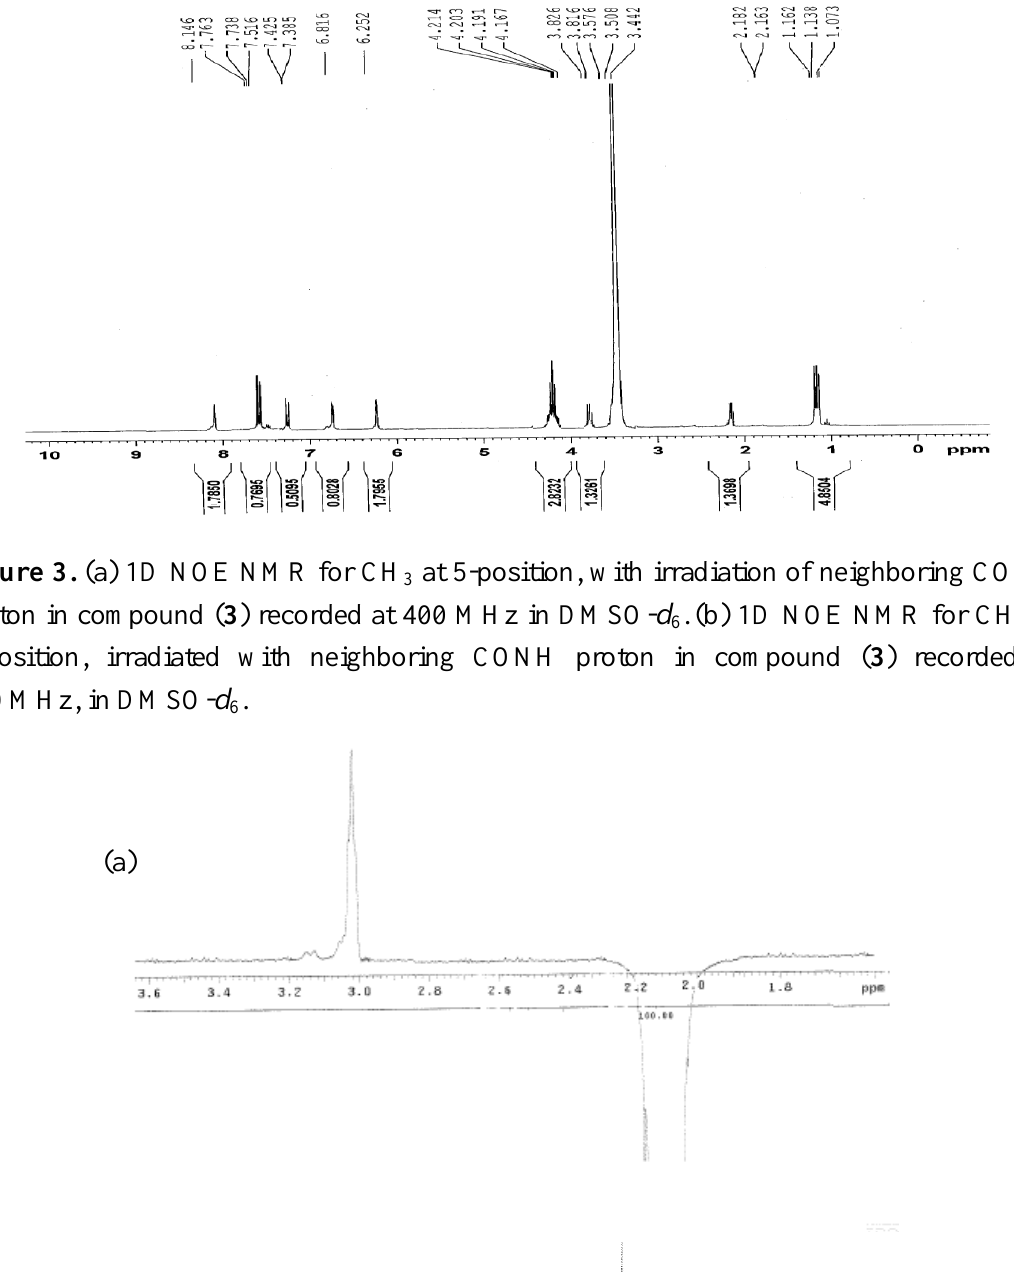
Figure 2. ¹H-NMR spectrum of compound ( 3 ) (400 MHz, DMSO- d